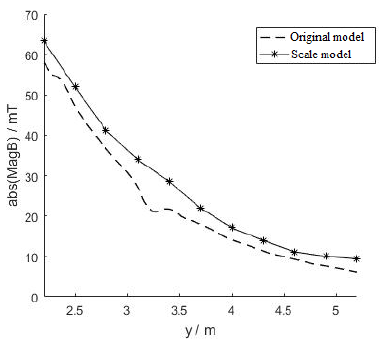
Figure 17. Central axial magnetic field of scaled model and actual reactor.